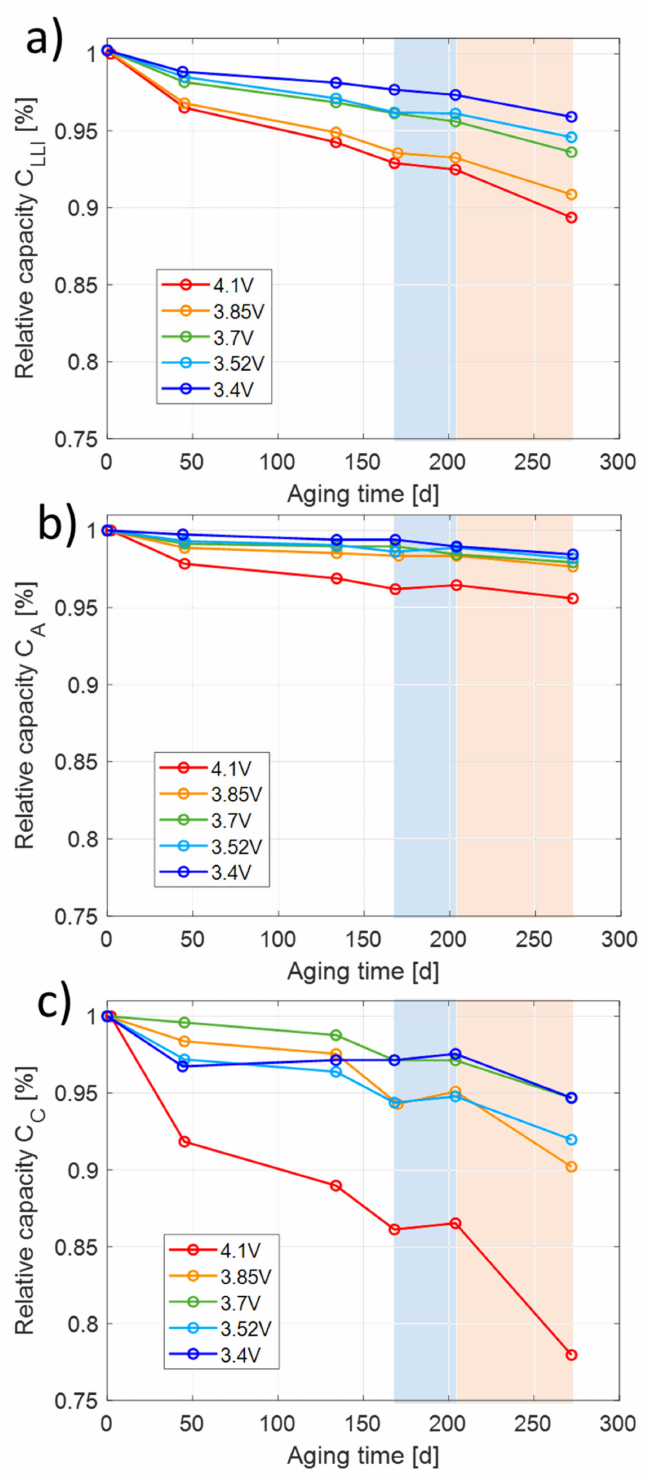
Figure 4. Loss of ( a ) active lithium C LLI , ( b ) anode active material C A and ( c ) cathode active material C C evaluated from DVA over test time for all five cell potentials. The low temperature cycle is in blue and the high temperature cycle in